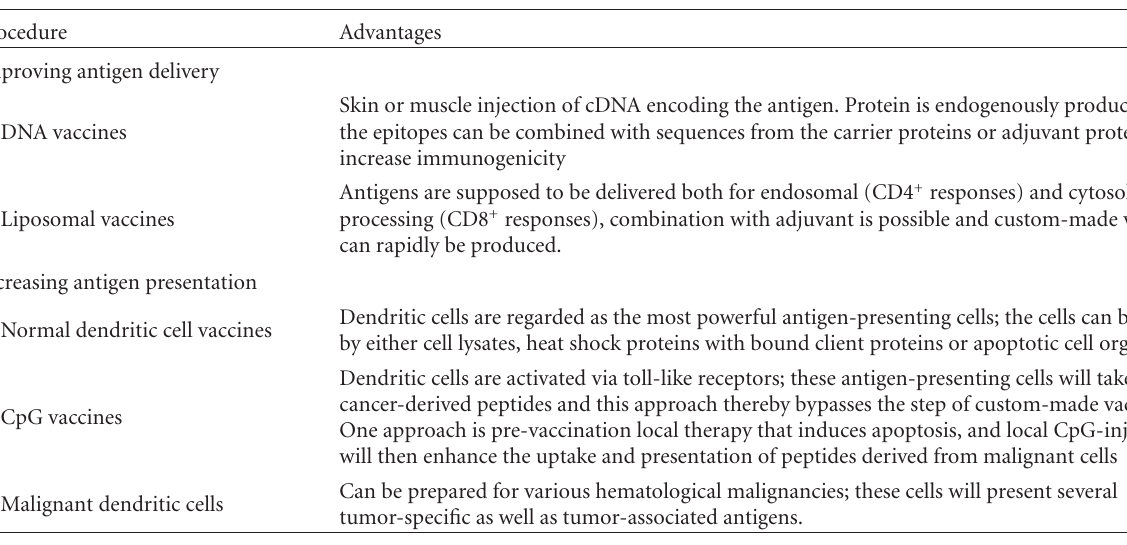
Figure 2: The immunostimulatory e ff ect of TLR9 ligation by CpG oligonucleotides. (a) TLR9 is normally activated by nonmethylated CpG dinucleotides (DNA motifs). In vaccination therapy TLR9 can be activated by synthetic oligodeoxynucleotides (ODN) containing CpG motifs (CPG ODN), these molecules can be linked to antigenic peptides (Ag CpG ODN). This complex is endocytosed by dendritic cells (DC); the antigen is then presented and CpG ODN enhances the accessory cell function of the dendritic cells [105–107]. (b) Binding of CpG ODN by TLR9 + dendritic cells initiates signal transduction through members of the IL-1 receptor-associated kinase (IRAK) family, mitogen activated kinases (MAPK) or Interferon (IFN) regulatory factors. These events lead to activation of nuclear factor kappa B (NF κ B) transcription factors with increased cytokine release and expression of costimulatory molecules [108]. (c) Inhibitory control mechanisms of CpG-mediated immune activation seem to include induction of IL-10, cyclooxygenase-2 (COX-2), NO synthase 2 (NOS-2) and prostaglandin E2 (PGE2). Intravenous administration of CpG ODN to mice induce splenic expression of the enzyme indoleamine 2,3- dioxygenase (IDO) that is an enzyme associated generation of regulatory T cells (Treg) and thereby inhibition of Th1 cells, cytotoxic T cells (Tc cells) and B cells [108]. Table 4: Preparation of vaccines for lymphomas, an overview of possible methodological approaches